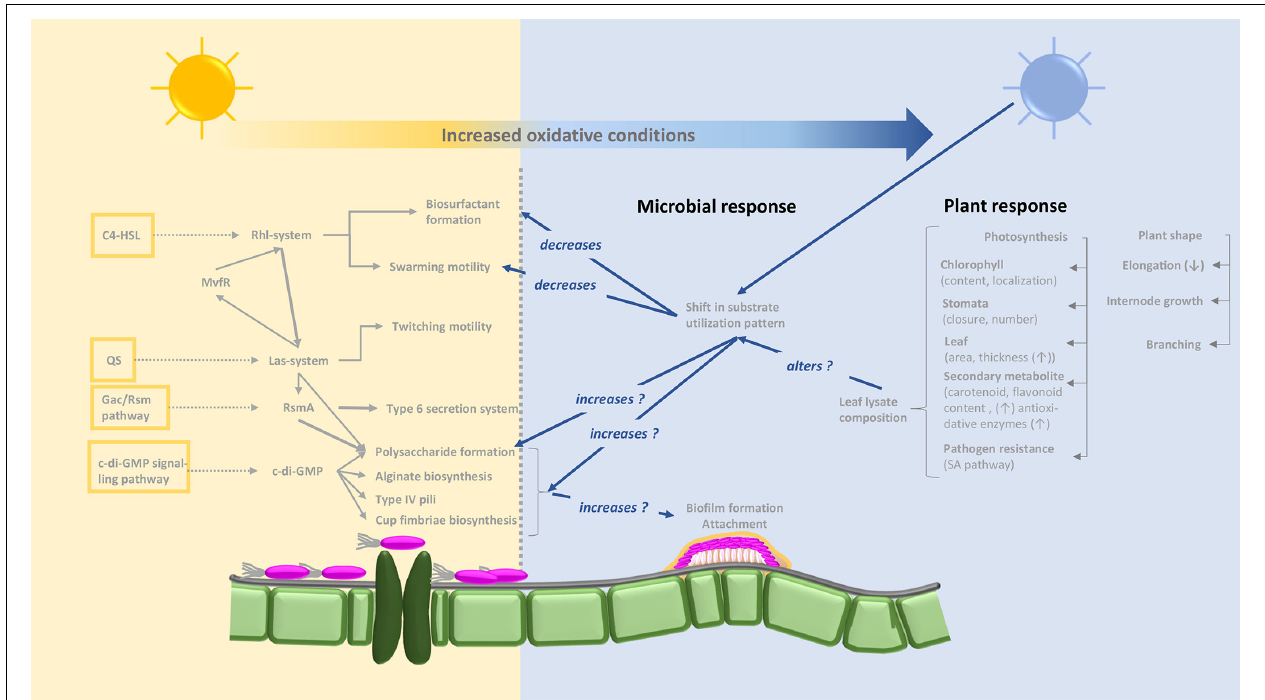
FIGURE 8 | Concept-based map illustrating putative interactions between light regime (non-blue light: yellow background; blue light: blue background), plant responses and responses of Pseudomonas sp. based on the results obtained and including literature knowledge. Pathways for biosurfactant and biofilm formation are based on Kyoto Encyclopedia of Genes and Genomes (KEGG) map02025 “Biofilm formation–Pseudomonas aeruginosa” (http://www.kegg.jp/kegg-bin/highlight_pathway?scale=1.0&map=map02025&keyword=biofilmPseudomonas). The yellow framed boxes on the left display pathways involved into biofilm formation and the dotted arrows link to the main signaling cascades. The C4-HSL = N -butyryl-l-homoserine lactone, links to the Rhl-system = two lux-type quorum sensing systems, and further to the Las-system. In Pseudomonas aeruginosa this is consisting of two components, namely an autoinducer synthesizing acyl homoserine lactone (AHL) from methionine and a transcriptional controller and mediates the formation of C4-HSL ( N -butanoyl homoserine) which enables communication between bacterial cells among others biofilm formation. Interlinked between these the MvfR = transcriptional regulator moderating the expression of QS-based virulence factors, mediates a feedback system. The QS, quorum sensing, also acts into the Las-system impacting together with the Gac, global regulatory system for activation of antibiotic and cyanide synthesis, the RmsA, small RNA binding protein; the Gac/Rms pathway allows the organism to switch between primary and secondary metabolism; c-di-GMP, Bis-(3 (cid:48) –5 (cid:48) )-cyclic dimeric guanosine monophosphate, then also majorly acts on processes of the biofilm formation via impacting features like Polysaccharide formation, alginate biosynthesis, etc. According to the experimental findings, it is clear, that blue light regimes impacts several features of bacterial habit in the indicated way. However, it needs further investigation to identify the molecular mechanisms and locations of these